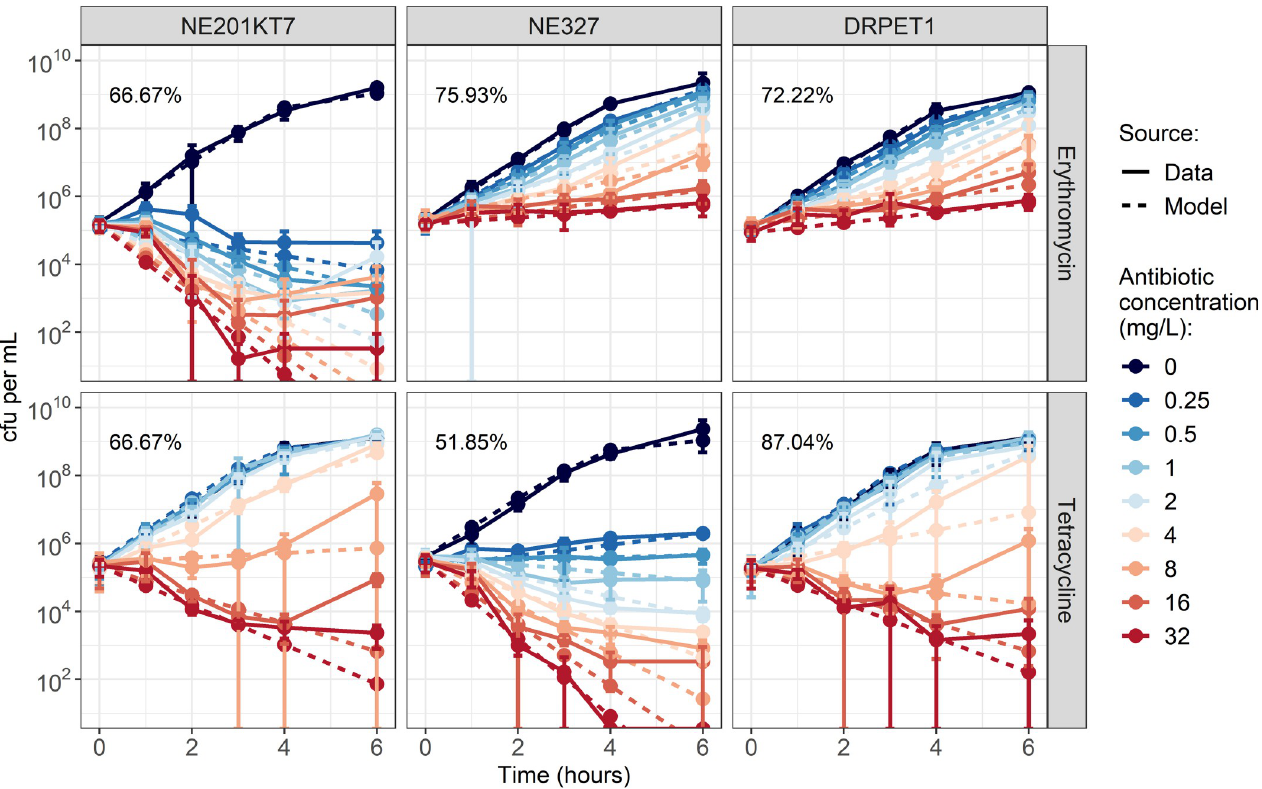
Fig 2. Growth curves of NE201KT7 (tetracycline-resistant, left), NE327 (erythromycin-resistant, middle) and DRPET1 (double-resistant, right), exposed to varying concentrations of erythromycin (top) or tetracycline (bottom). Solid lines show in vitro data, with error bars indicating mean +/- standard deviation, from 3 replicates. Dashed lines show model output after fitting. Values indicate the percentage of model points that fall within the range of the corresponding in vitro data point +/- standard deviation. cfu: colony-forming units. Note that cfu per mL are shown on a log-scale.